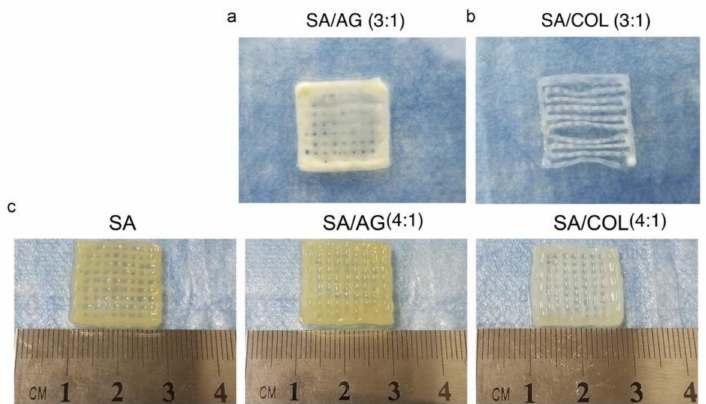
Figure 6. Small grids by 3D printing. ( a ) sodium alginate/agarose (3:1), ( b ) sodium alginate/collagen (3:1), and ( c ) sodium alginate, sodium alginate/agarose (4:1) and sodium alginate/collagen (4:1). Reproduced from [116] with permission. Copyright (2018) Elsevier.